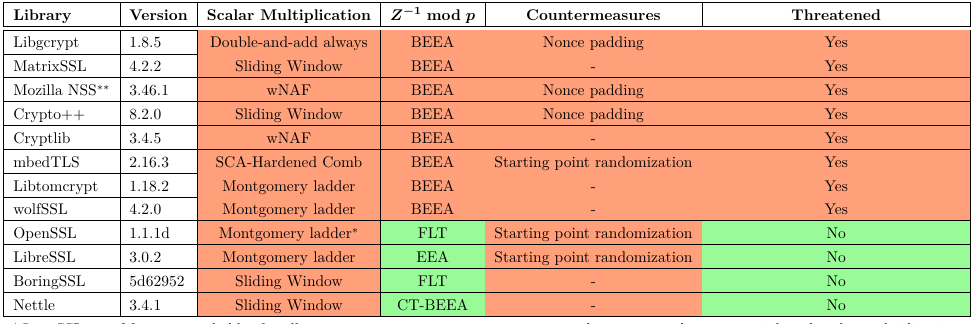
Table 1: Open-source library status regarding the projective coordinates attack.